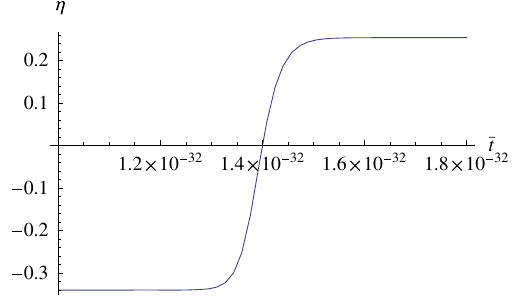
Fig. 2 The evolution of η with respect to the cosmological time ¯ t . The time is expressed in seconds. The value of the parameter γ is assumed = 0 . 6911, where as 3 . 277 × 10 − 6 s 2 Mpc 2 . We also assume that Λ km 2 3 H 2 0 H 0 = 67 . 74 km . Note that η is not a constant function when matter s Mpc is not negligible (see Fig. 4). It is interesting that the function η is of logistic-like function